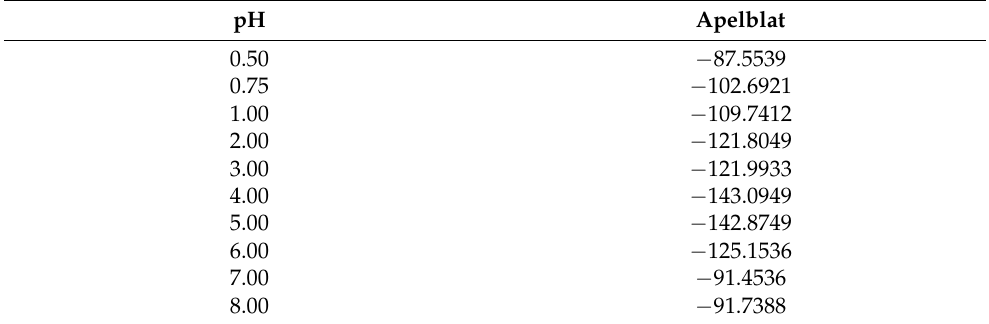
Table 8. Calculation results of AIC value of 7-ADCA correlation solubility and temperature model.